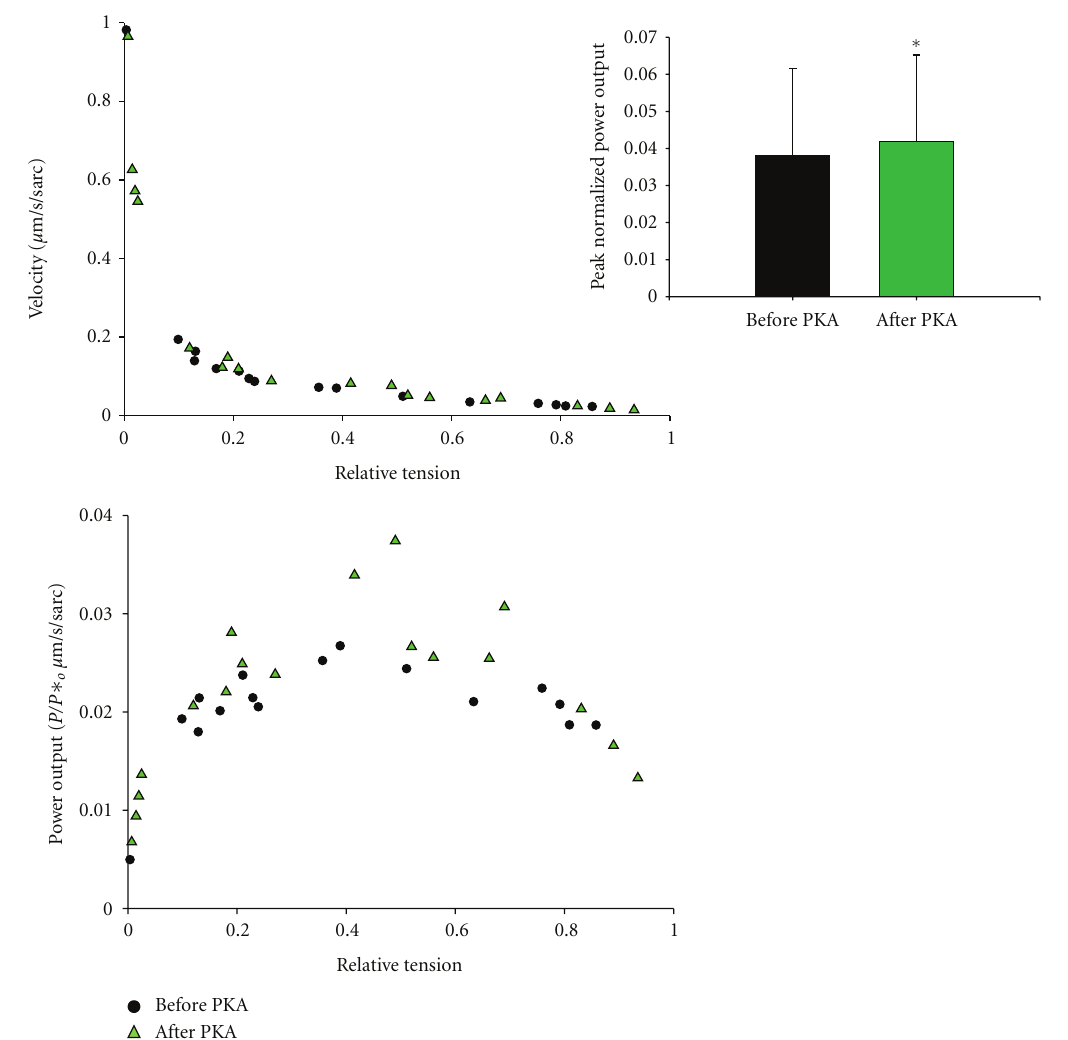
Figure 6: Normalized force-velocity and power-load curves from a pig left ventricular myocyte preparation before and after PKA treatment during half-maximal Ca 2+ activations. Pig cardiac myocyte preparations exhibited more power after PKA treatment. Inset shows bar plot (mean ± SD) of peak normalized power output before and after PKA ( n = 10 myocyte